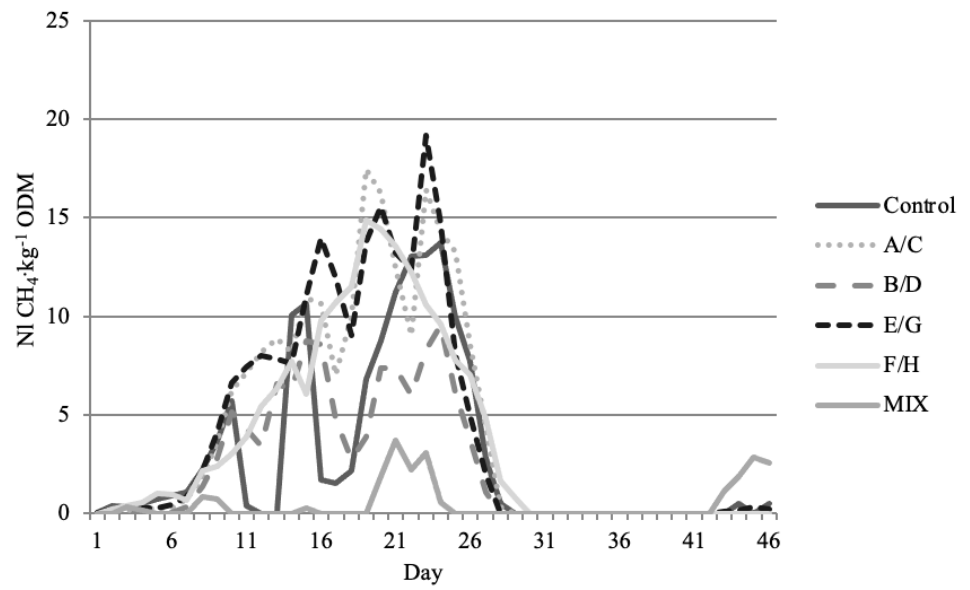
Figure 5. Daily yield of methane in the analyzed variants.